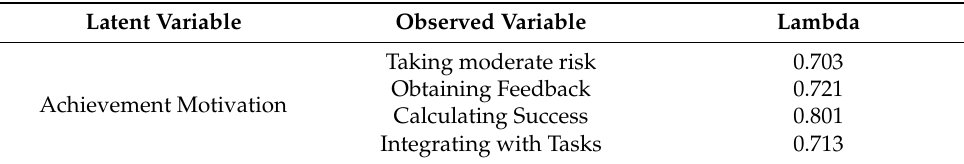
Table 3. The measurement model of student achievement motivation variable.